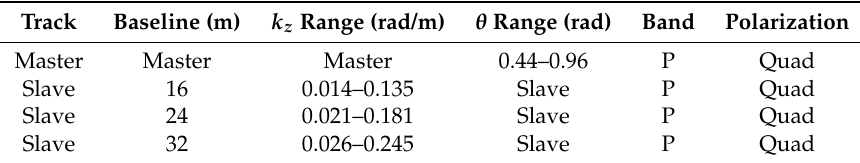
Figure 7. Pauli-basis polarization composite map. Table 1. Pol-InSAR data